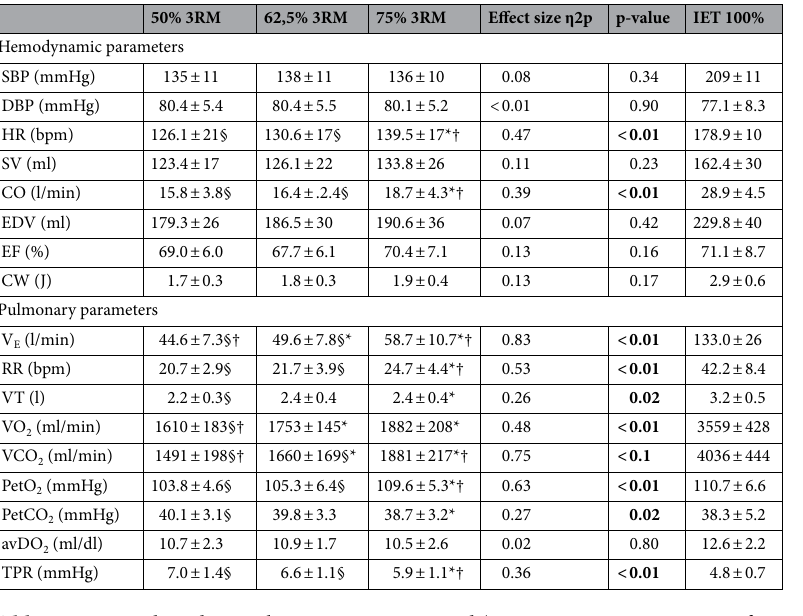
Table 3. Mean values during the post-exercise period (n = 14; mean at one minute after exercise periods). Significant values are in bold. Values are presented as the means and standard deviation; IET incremental exertion test (the displayed IET data were not included in the ANOVA and only for illustration), η2p partial eta-squared of the one way repeated measures ANOVA (50% weight loads, 62.5% weight loads, 75% weight loads), SBP systolic blood pressure, DBP diastolic blood pressure, HR heart rate, SV stroke volume, CO cardiac output, EDV end-diastolic volume, EF ejection fraction, CW cardiac work, V E ventilation, RR respiratory rate, VT tidal volume, VO 2 oxygen uptake, VCO 2 carbon dioxide output, PetO 2 end-tidal oxygen partial pressure, PetCO 2 end-tidal carbon dioxide partial pressure, avDO 2 arteriovenous difference of oxygen, TPR total periphery resistance, * (P < 0.05) different from 50% intensity; † (P < 0.05) different from 62.5% intensity; § (P < 0.05) different from 75%